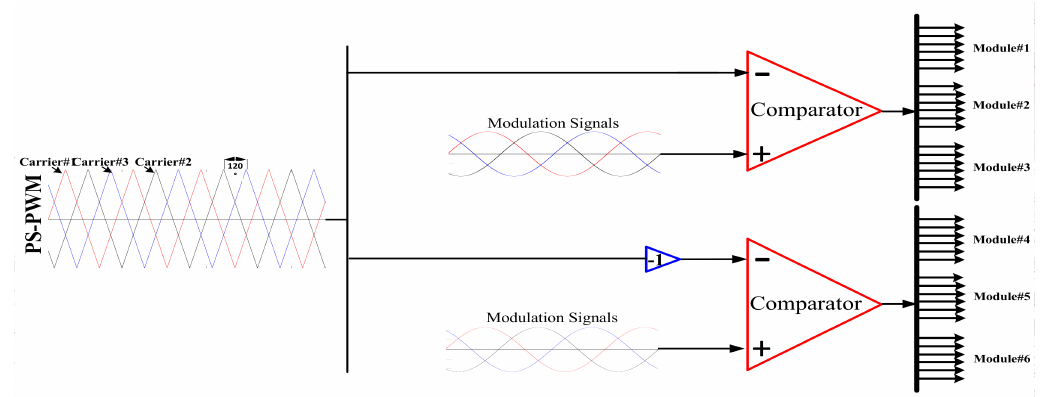
Figure 4. Proposed PS-PWM diagram.